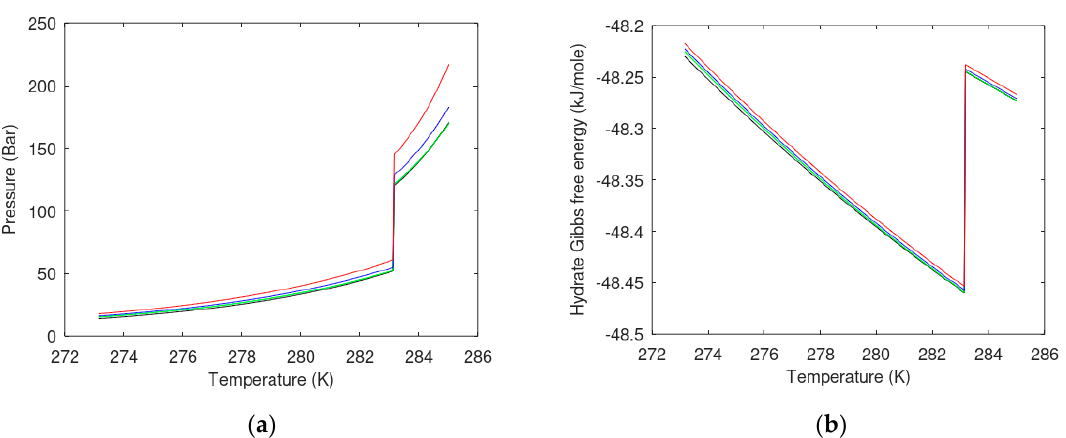
Figure 3. ( a ) Temperature pressure stability limits for CO 2 hydrate formed from CO 2 and water containing ethanol. Black curve is for 0 mole-fraction ethanol, green is for 0.015 mole-fraction ethanol, blue is for 0.02 mole-fraction ethanol, and red is for 0.03 mole-fraction ethanol. ( b ) Gibbs free energy for hydrates formed from CO 2 and water containing various concentrations of ethanol. The color codes are the same as in Figure 3a.